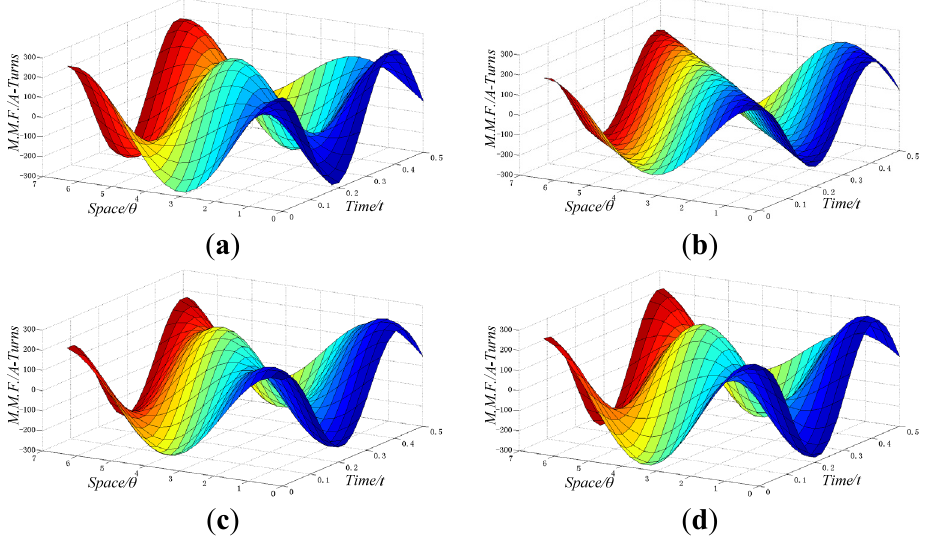
Figure 14. The MMF distributions in time and space; ( a ) Adjacent, apart by 30°; ( b ) Adjacent, apart by 90°; ( c ) Nonadjacent, apart by 120°; ( d ) Nonadjacent, apart by